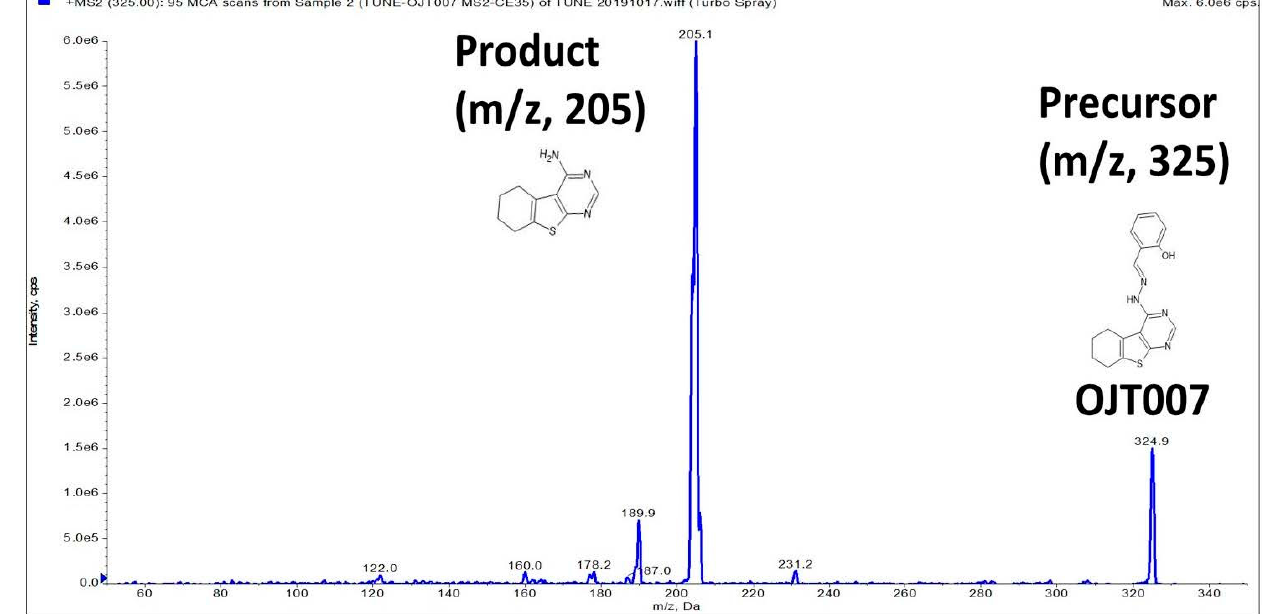
Figure 2. Product ion scan spectra for OJT007 ( m / z 324.9 → 205.1).